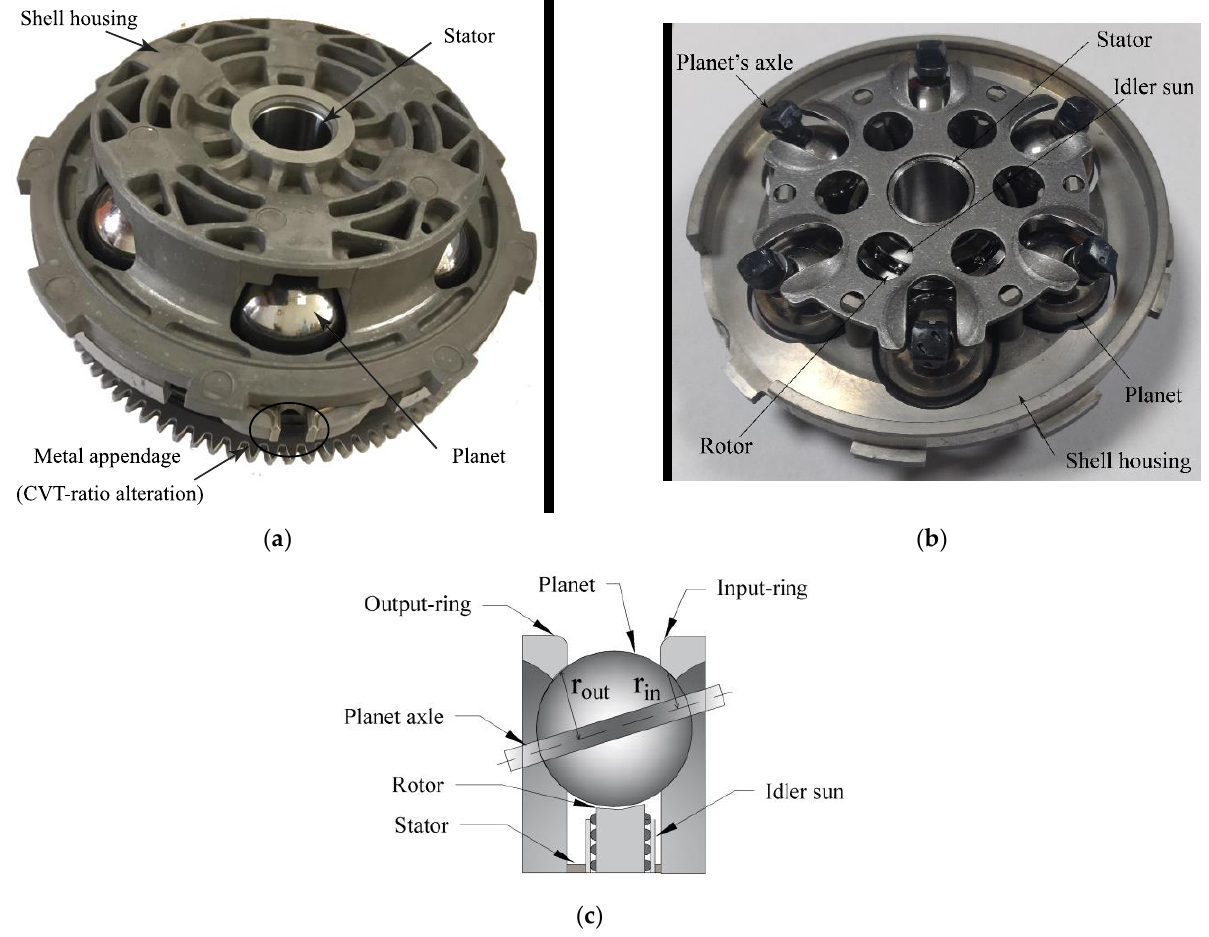
Figure 3. Core of the continuously variable transmission (CVT): ( a ) perspective ( b ) cross section photograph ( c ) diagrammatic view in overdrive mode.